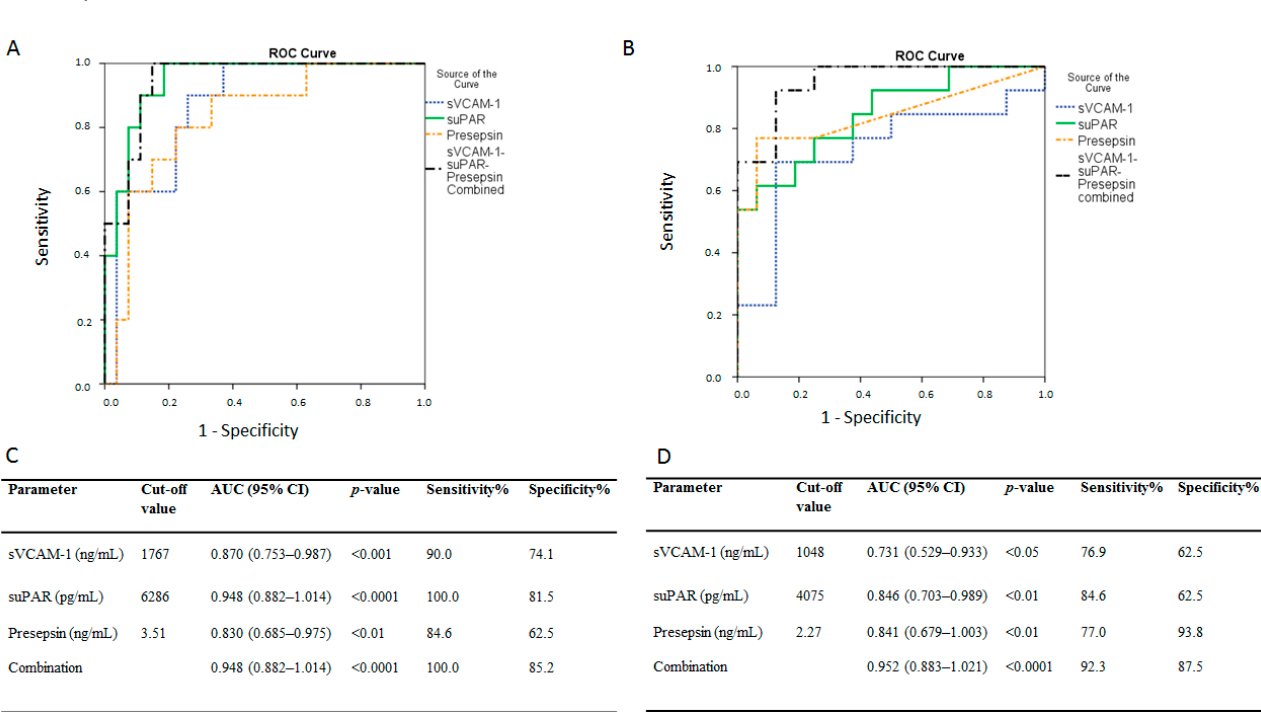
Figure 5. Admission biomarker levels and intensive care unit (ICU) mortality. Receiver operating characteristic (ROC) curve analysis. ROC curves were generated to determine the prognostic accuracy of either suPAR, sVCAM-1, presepsin, or their combination, as measured on ICU admission (within 24 h). ROC curves in ( A ) the dexamethasone-free group and ( B ) the dexamethasone-treated (first dose—6 mg) group. suPAR, solid line; sVCAM-1, dotted line; presepsin, dashed line; combination, dash-dotted line. ( C – D ) the corresponding areas under the curve (AUC), 95% confidence intervals (CI) and the optimal cut-off values with the greatest combined sensitivity and specificity are given. suPAR = soluble urokinase-type plasminogen activator receptor; sVCAM-1 = soluble vascular cell adhesion molecule-1.